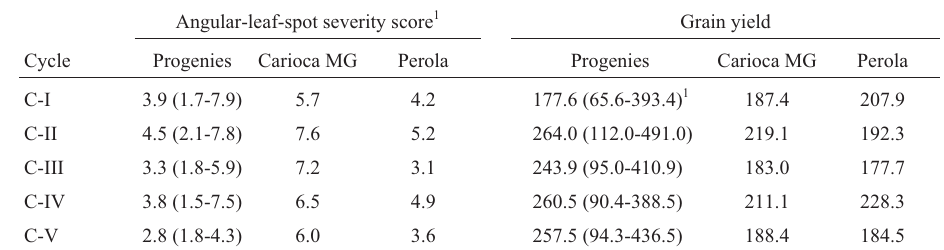
Table 3 - Angular-leaf-spot severity score (1 = minimum, 9 = maximum) and grain yield in g m -2 of the progenies and the Carioca MG and Pérola checks assessed from the first (C-I) to fifth (C-V) recurrent selection cycle.